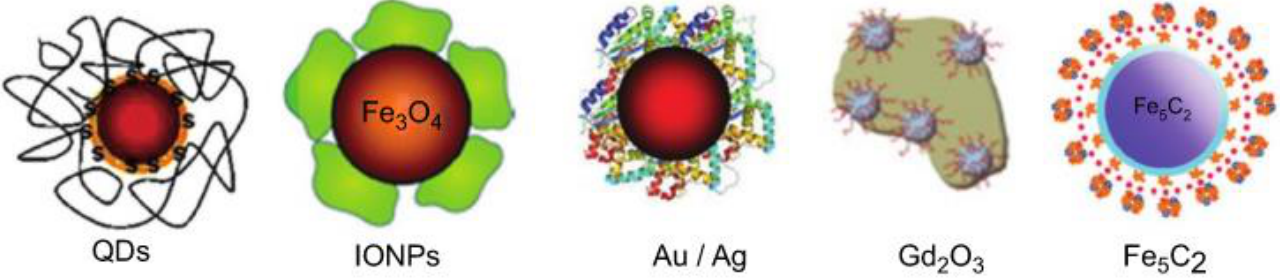
Figure 5. Representation of the surface modification of different types of NPs with albumin. Repro- duced from ref. [47], copyright 2016, with permission from John Wiley and Sons.